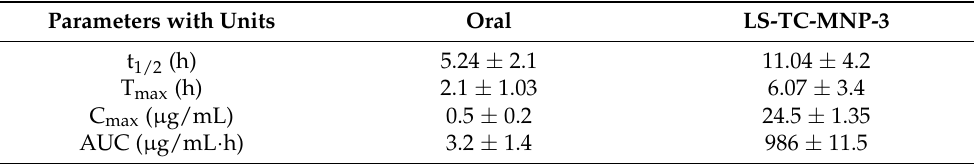
Table 3. Pharmacokinetic parameters of in vivo study up to 48 h after administration of oral dose and LS-TC-MNP-3 fabricated from thiolated chitosan (applied on the back of mice) (mean ± SD, n = 4). Parameters with